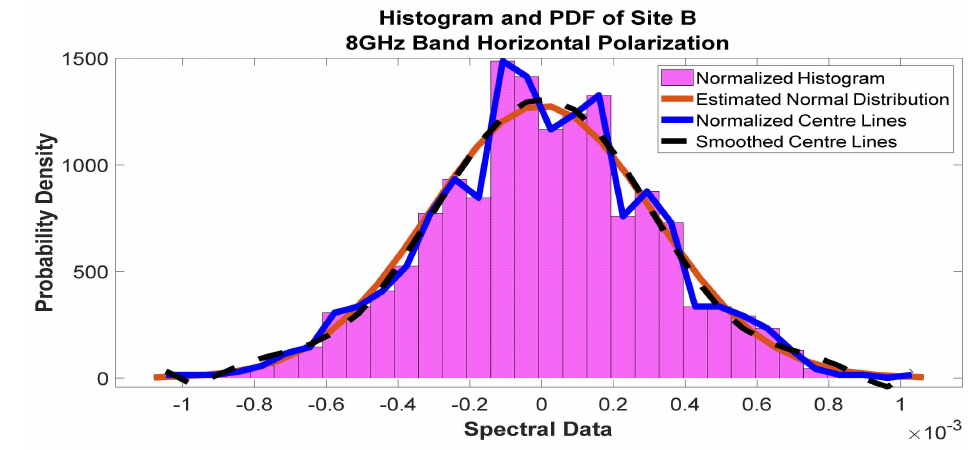
Figure 28. Histogram and PDF of the frequency scan for site B at 8 GHz horizontal polarization.